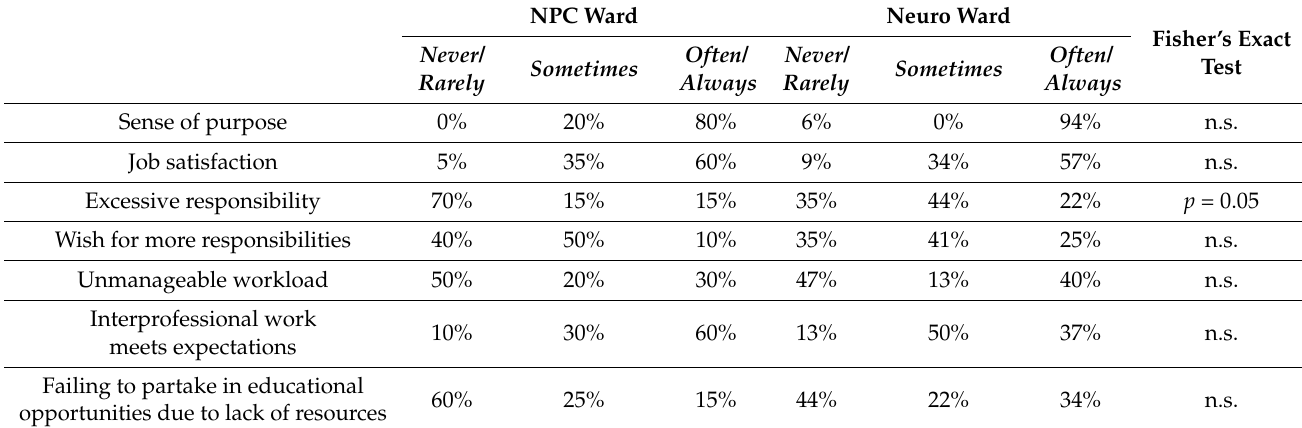
Table 2. Perceived frequency of institutional and interpersonal burdening events on the NPC ward and the neuro ward in relative numbers. The occurrence of burdening events is summarized as “never”, “rarely”, “sometimes”, “often”, and “always” to “never/rarely”, “sometimes”, and “of- ten/always”. NPC Ward Neuro Ward Fisher’s Exact Often/ Often/ Never/ Never/ Test Sometimes Sometimes Always Always Rarely Rarely 0% 20%